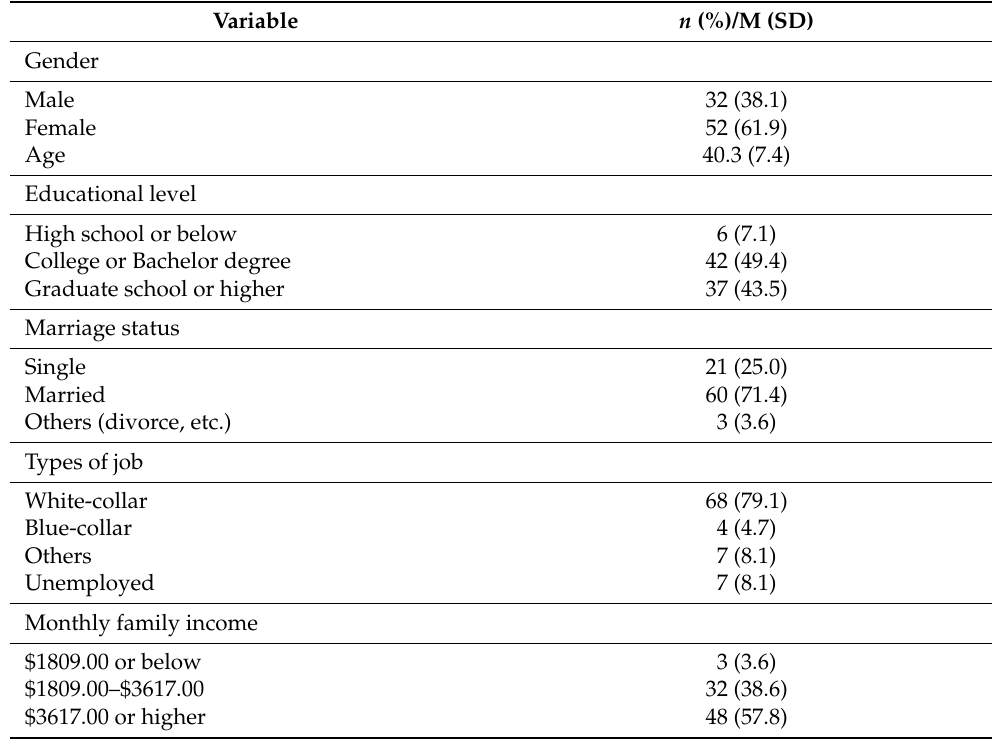
Table 1. Demographic characteristics of Korean workers ( n = 95, valid case